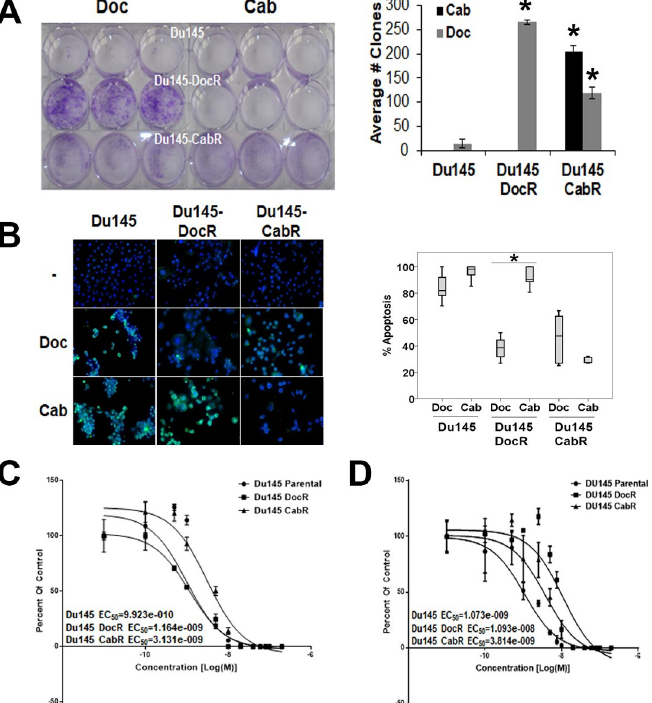
Fig 2. In vitro validation of the resistance against taxanes in Du145 cells. (A) Left panel: representative pictures showing the formation of clones by Du145 age-matched, DocR and CabR cells under 50nM Doc or Cab. Right panel: Quantification of clone formation counted 30 days after ending the treatment. Error bars: mean ± SD from triplicates. � : P < 0.05 showing statistical significance. (B) Left panel: Representative pictures of apoptosis in Du145 age matched, DocR and CabR resistant cells using TUNEL assay. Cuts in DNA (Green) and nucleus staining with DAPI (Blue) are shown. Right panel: quantification of apoptosis (Boxplot graphs showing the median, inter-quartile range, upper and lower quartiles, and whiskers) measured from more than 300 cells per condition treatment. The experiment was repeated three times. Statistical analysis was performed using one-way ANOVA on Ranks, Kruskal-Wallis Analysis, followed by Dunn’s post-hoc test. � P < 0.05). (C-D) Growth curves of age-matched, DocR and CabR cells under increasing concentration of Doc (C) or Cab (D). After 24 hours treatment, cells were fixed, stained using crystal violet solution, rinsed and air dried. Alive cells [cells that do not present cell death signs within the nucleus (chromatin condensation and chromosomal DNA fragmentation visualized by DAPI staining)] were then counted in each well. Each treatment condition was tested in triplicate; each experiment repeated at least three times. Quantification was done from three different experiments and data are expressed as mean ± SD.